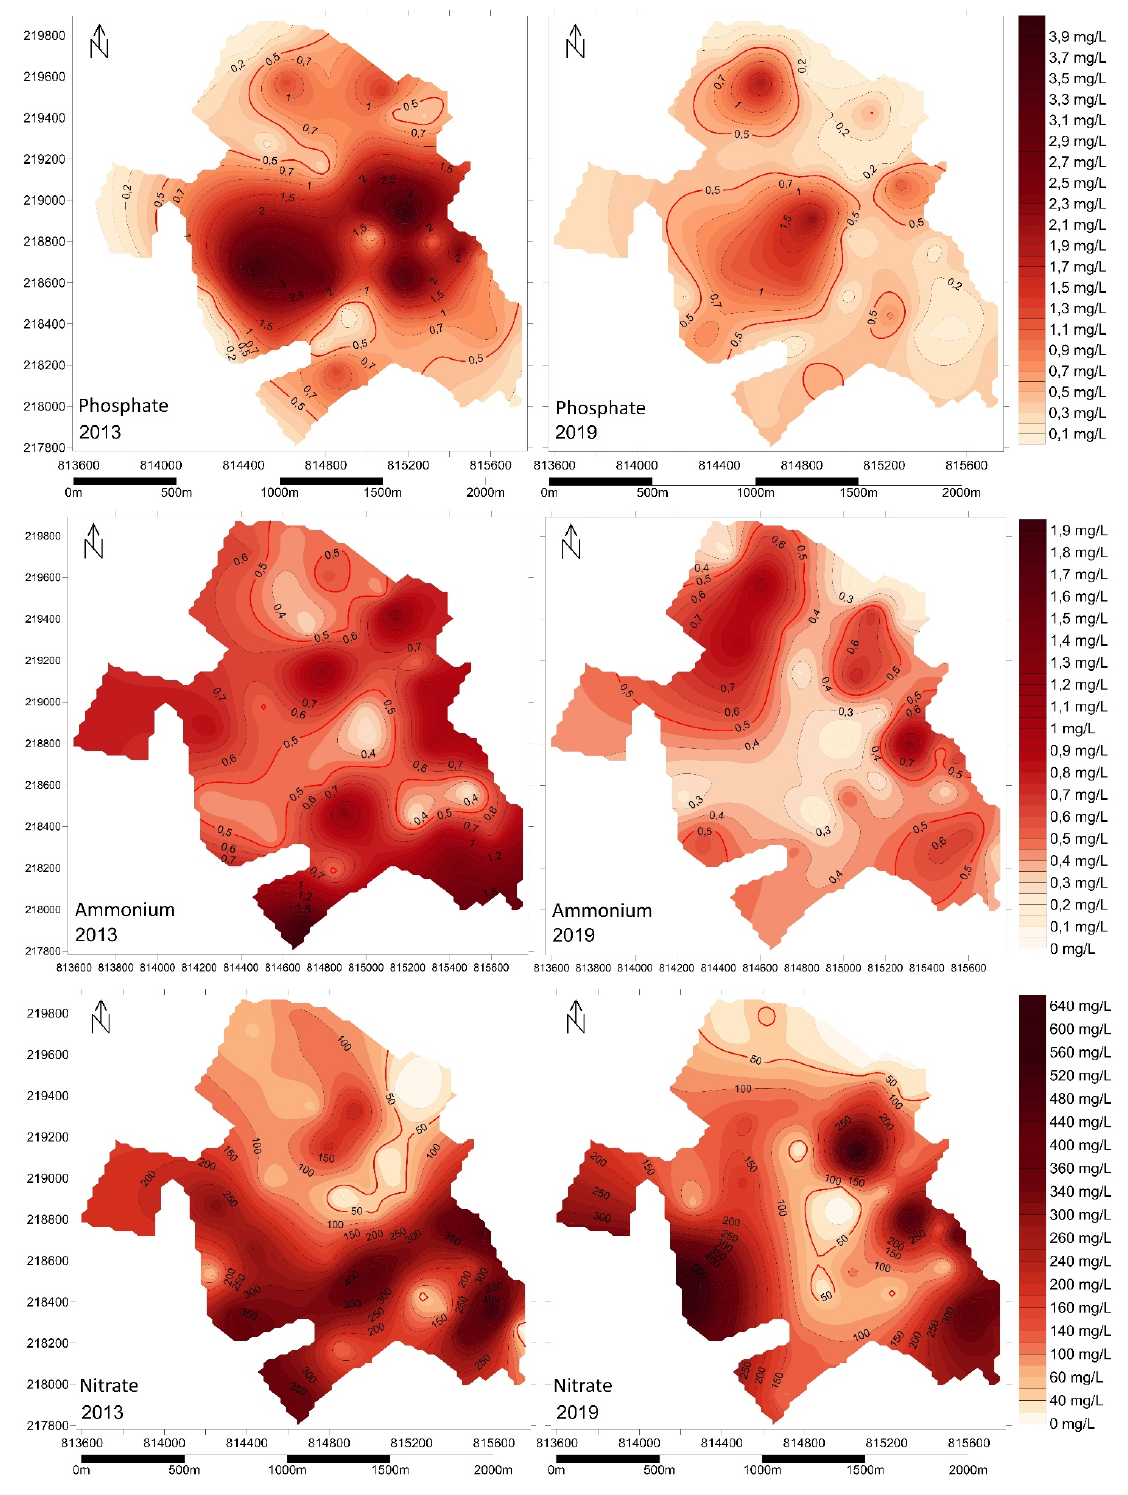
Figure 5. Spatial distribution of PO 4 3 − , NH 4 + and NO 3 − concentration before (2013) and five years after the establishment of the sewerage network (2019).